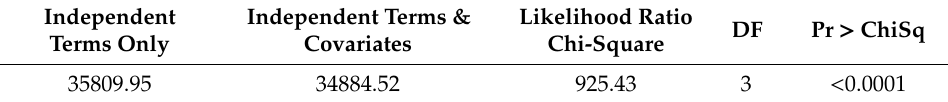
Table 12. Final regression model